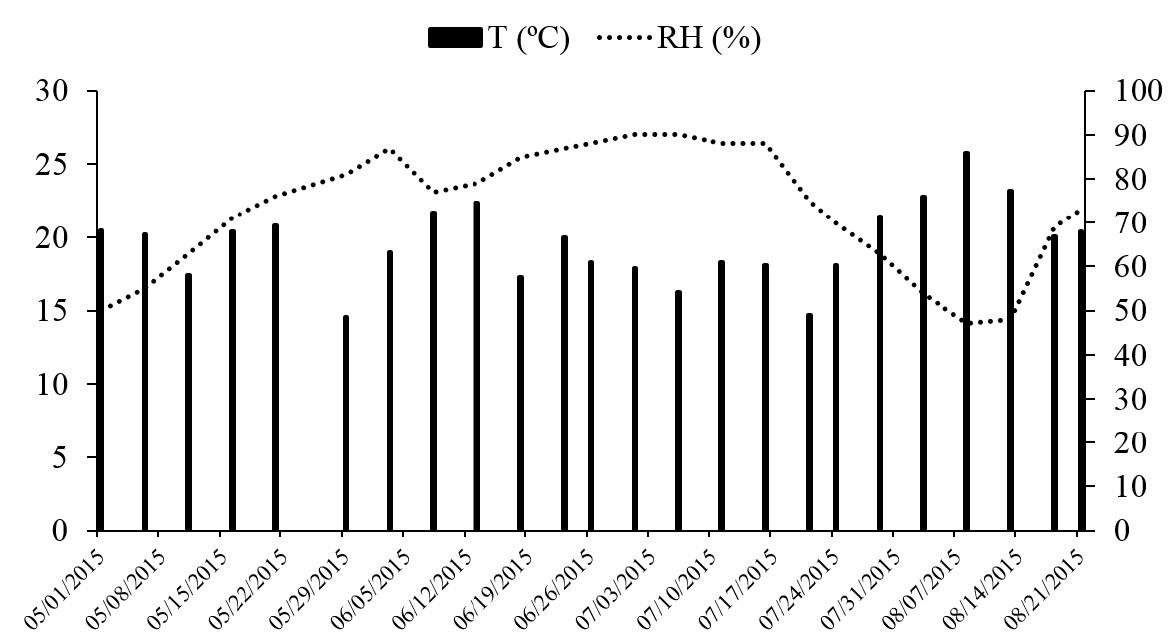
Figure 1 - Temperature and relative humidity during the experimental conduction